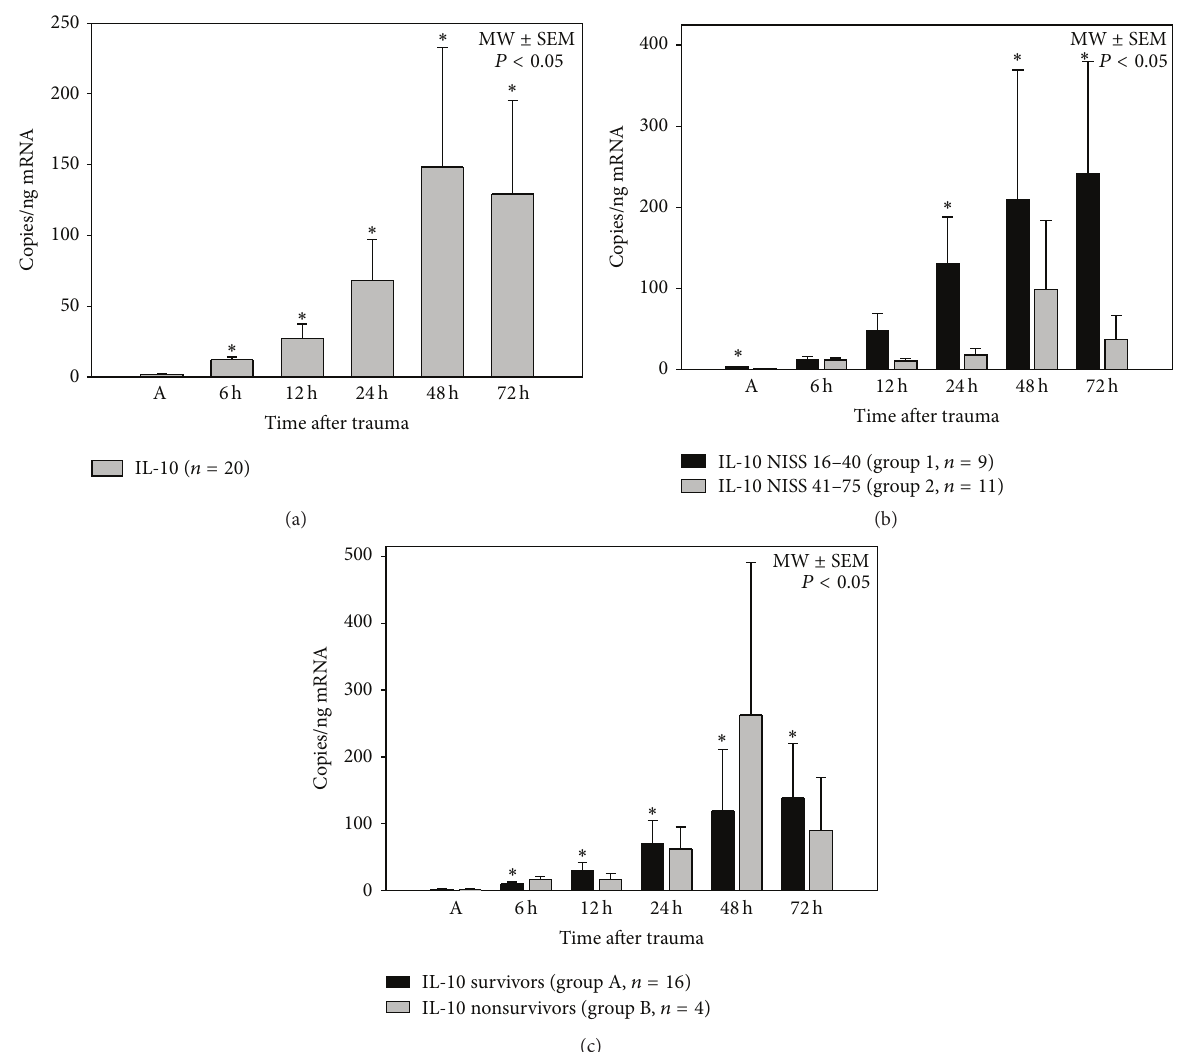
Figure 1: Posttraumatic IL-10 mRNA expression profile after major trauma in all patients (a), depending on injury severity (NISS, (b)) and depending on outcome (survival > 90 days, (c)), ∗ 𝑃 < 0.05 SNK-test. IL-10 mRNA expression after blunt multiple trauma increased significantly in the early posttraumatic period (6h–72 h) compared to IL-10 mRNA expression immediately after trauma on admission (A). Patients with a NISS less than 41 points expressed significantly higher IL-10 mRNA levels on admission (A), 24 h, 48 h, and 72 h after trauma, compared to patients with a NISS between 41 and 75 points. Patients who survived the traumatic event showed a significant increase of IL-10 mRNA expression on each time point (6h–72 h) compared to the IL-10 level detected on admission